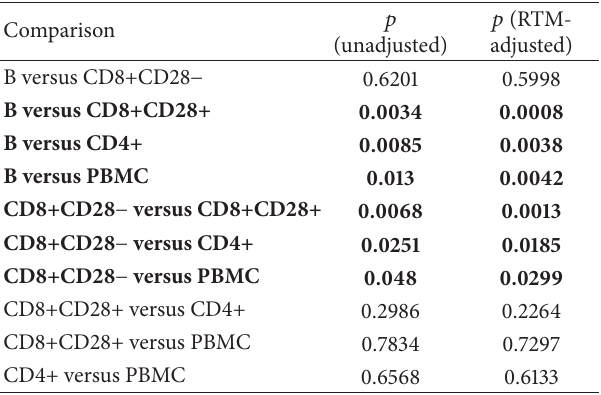
Table 6: Comparison of telomere length change in different cell types (adjusted 𝑝 values).